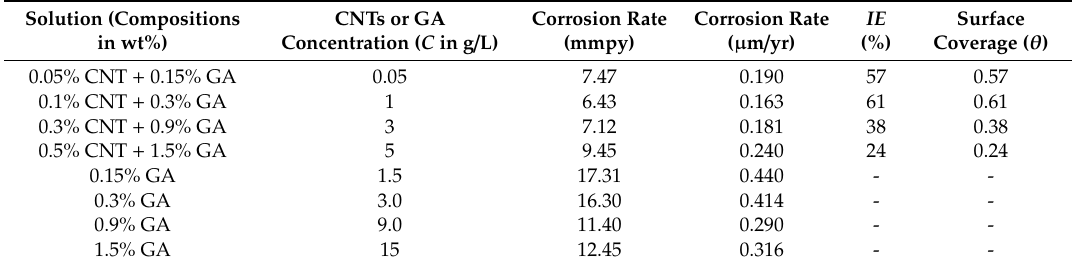
Table 6. Inhibition e ffi ciency ( IE %) and surface coverage ( θ ) of 316L stainless steel samples tested in di ff erent CNT nanofluids (mmpy is milli mil per year and µ m / yr is micrometer per